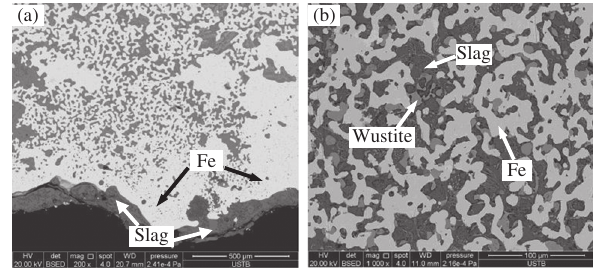
Figure 11: The microstructure of sinter particle with shrinkage rate at 60% under high reduction potential condition. (a) Granule structure; (b) microstructure.